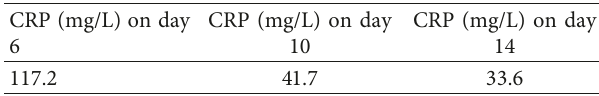
Figure 2: Patient’s right forearm improvement 10days after appropriate antifungal therapy. Table 3: C-reactive protein trend in response to antifungal